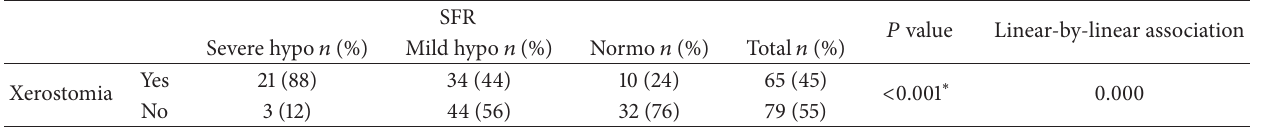
Table 4: Prevalence of xerostomia